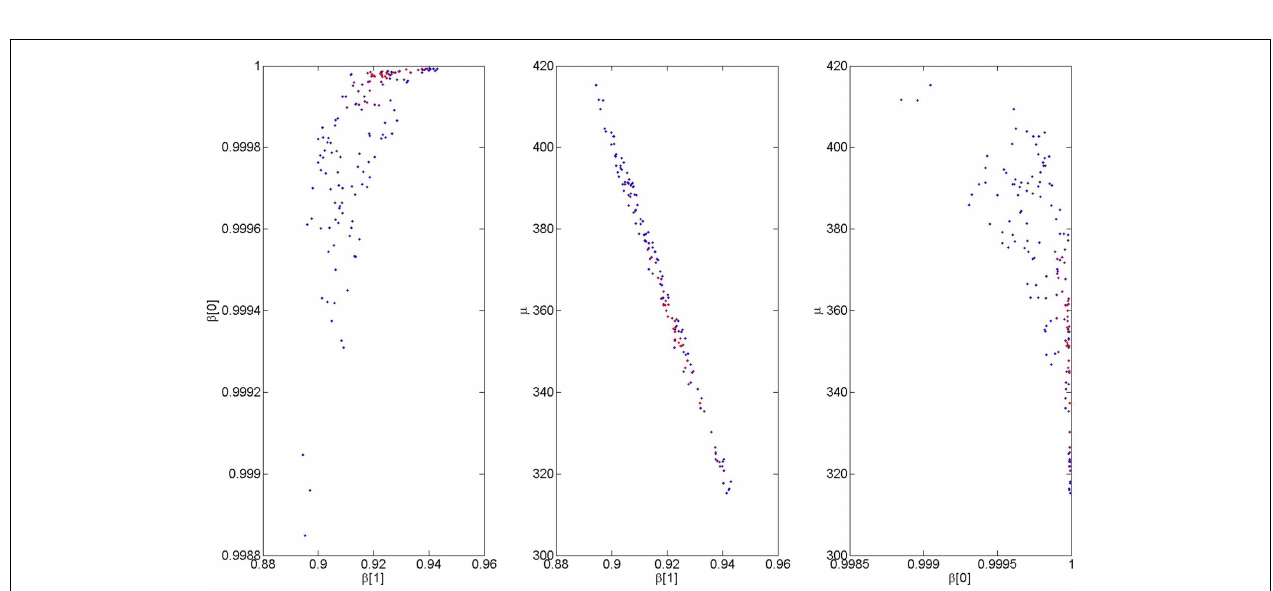
FIGURE 6 | Inferring faulty accumulation (left) participants are more likely to attribute errors ( b = 0) to incorrect accumulation ( c = 0) for larger values of π (red curve). Conversely, participants are more likely to attribute correct responses ( b = 1) to incorrect accumulation for smaller values of π (blue curve).These curves were computed from equation (3) (red) and equation (4) (blue) with a value of β t = 0.9.The blue and red